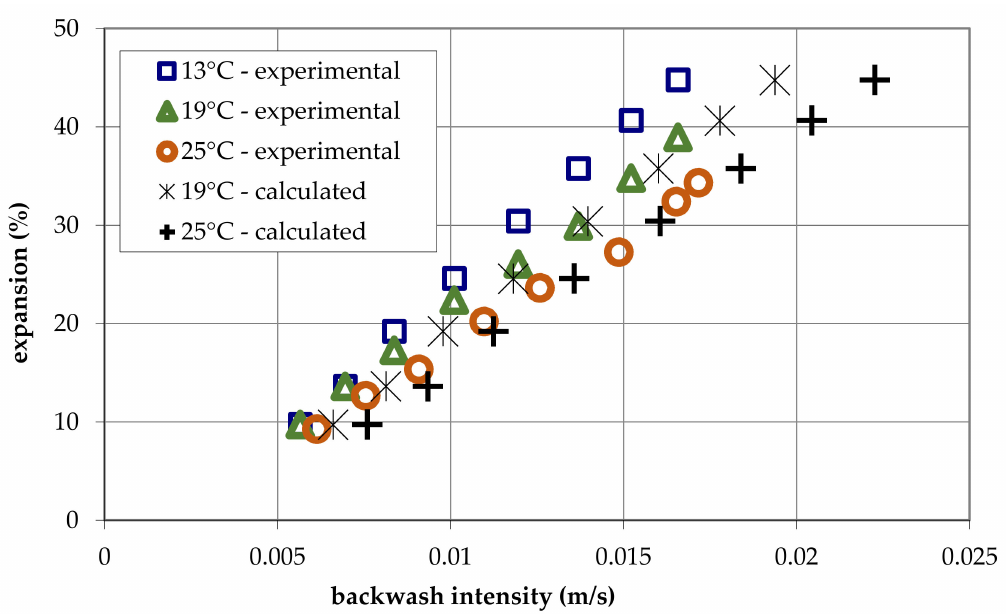
Figure 6. Result of fitting calculated values of bed expansion to measured values for temperatures of 13 ◦ C and 25 ◦ C.